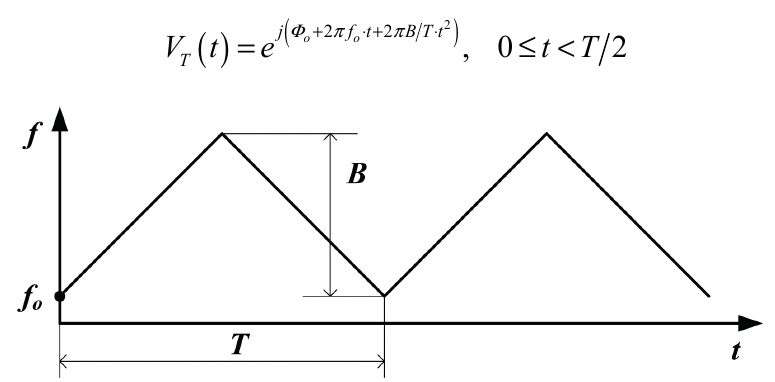
Figure 4. Instantaneous frequency of the transmitted